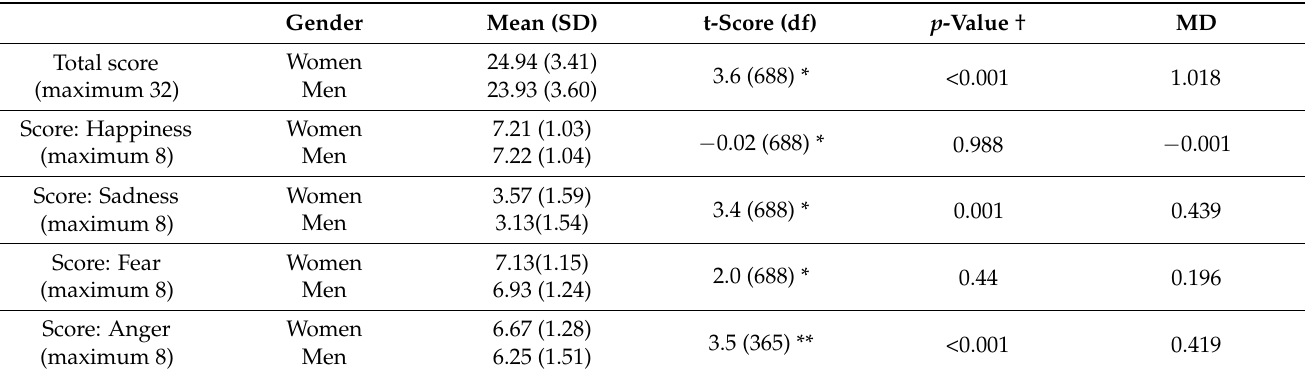
Table 2. Success scores of the participants according to gender and emotion (mean [standard devia- tion], t-score [degrees of freedom], p -value and mean difference) ( n = 690). Gender Mean (SD) t-Score (df)